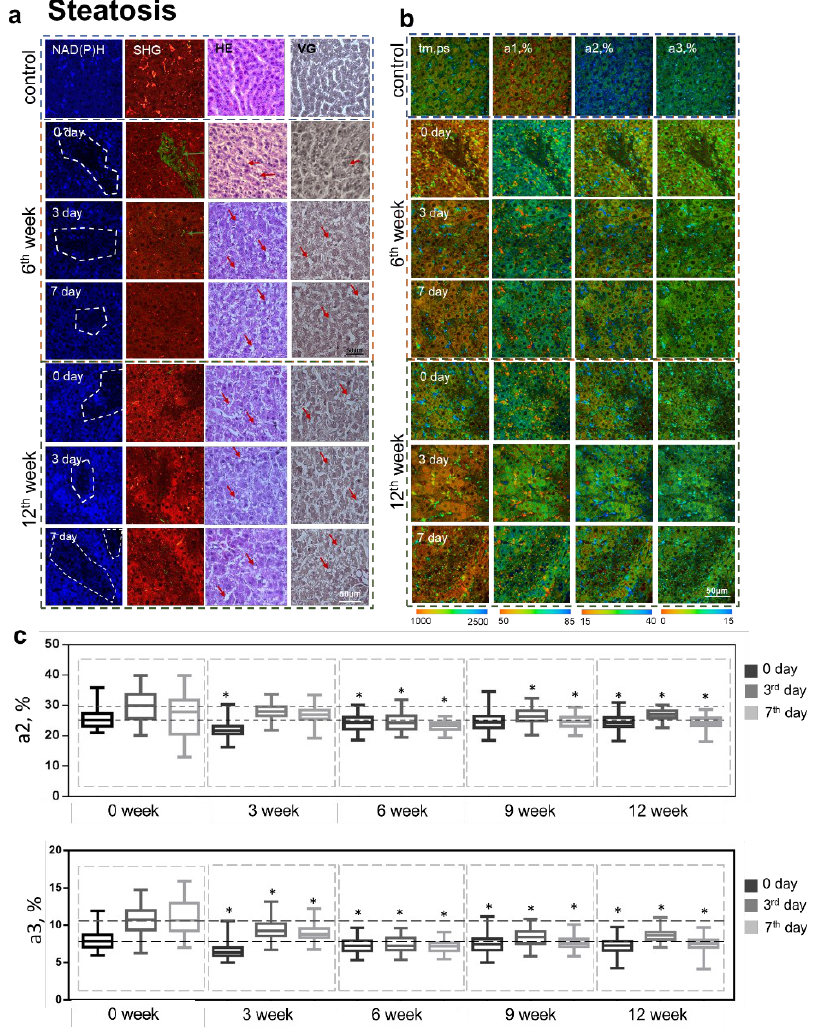
Figure 3. Analysis of the structural and functional state of liver tissue at different stages of steatosis during induced regeneration. ( a ) Fluorescence intensity images of NAD(P)H autofluorescence (leftmost column); NAD(P)H: excitation at 750 nm, detection range 455–500 nm. Second left column: cell autofluorescence (red): excitation at 800 nm, detection range 433–660 nm, SHG of collagen (green): excitation at 800 nm, detection range 371–421 nm; green arrows indicate collagen. Histological images: hematoxylin and eosin (HE) (second right column) and Van Gieson (VG) (rightmost column) staining; red arrows indicate lipid droplets. ( b ) Pseudo-coded FLIM images at different stages of steatosis during induced regeneration: before PH (0 day) and on the 3rd and 7th days after PH. ( c ) Boxplots reflecting the distribution of the values of the fluorescence lifetime contributions of the bound form of NADH and NADPH. The dotted line marks the medians of the parameter values for normal regeneration; scale bar 50 µ m; × 400. *—statistically significant differences compared to the corresponding time point for normal regeneration, p -value ≤